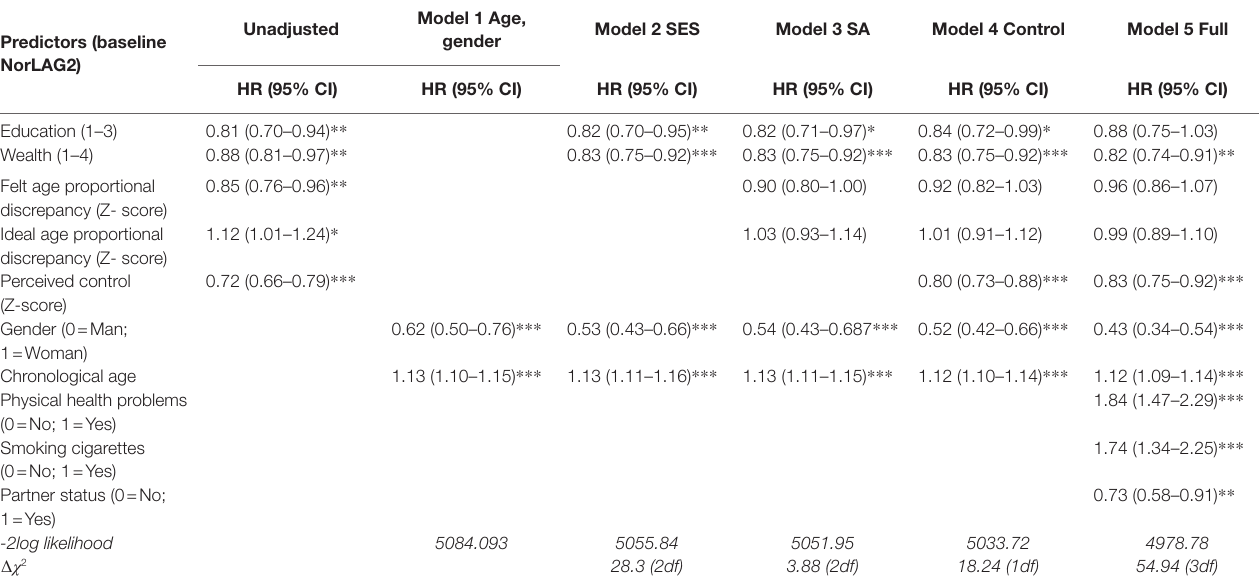
TABLE 3 | Mortality risk in older adults (67+). Bivariate coefficients for and stepwise Cox proportional hazards regression analyses ( N = 1,432). Hazard Ratios (HR) and 95% Confidence Intervals (CI).